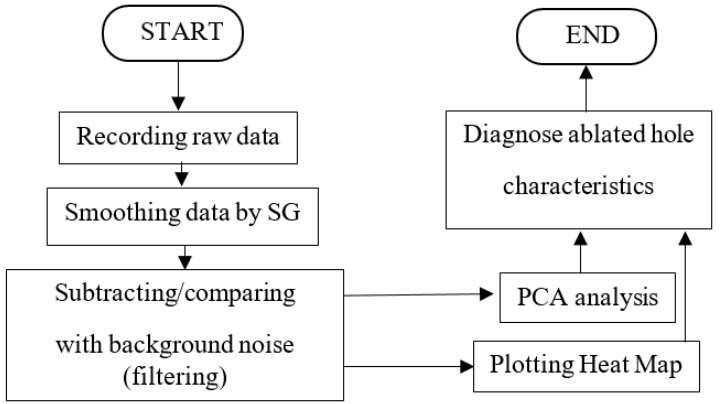
Figure 2. Diagram/flowchart of in-process techniques to find the correlation between recorded data and microscopic